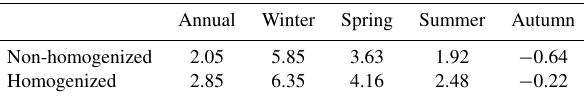
Table 1. Linear trends (% per decade) of all annual and seasonal precipitation anomaly series (1961–2018) before and after homog- enization. Annual Winter Spring Summer Autumn Non-homogenized